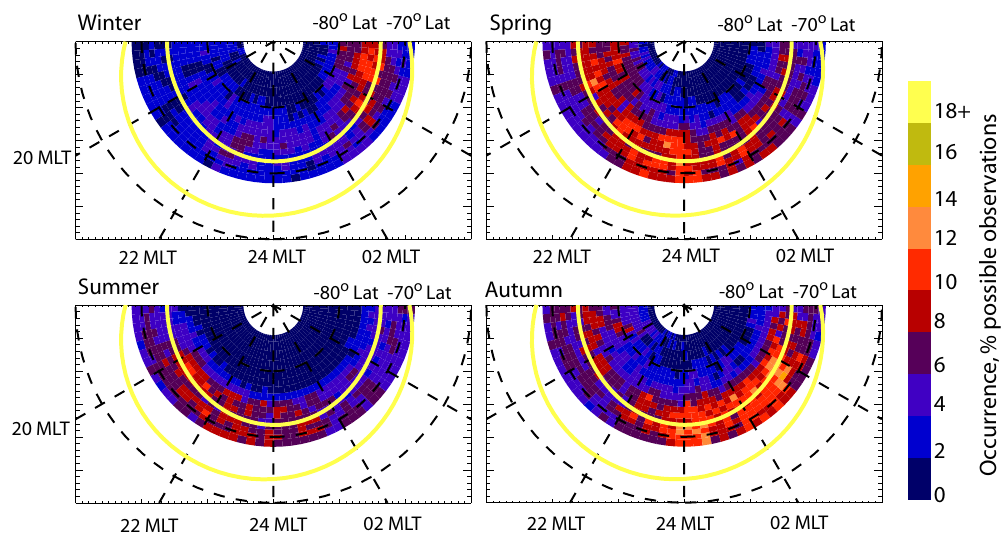
Fig. 3. Colour-coded plots of the data occurrence observed by the Syowa East radar as a function of Southern Hemisphere season, MLT and latitude for the three years of data. Each square of colour represents an interval of 15min of MLT and one statistical summary point. The colour scale indicates the number of observations of ionospheric scatter above 3dB as a percentage of the total possible observations in that season from the database used. A statistical auroral oval for a K p of 2 is overlaid for